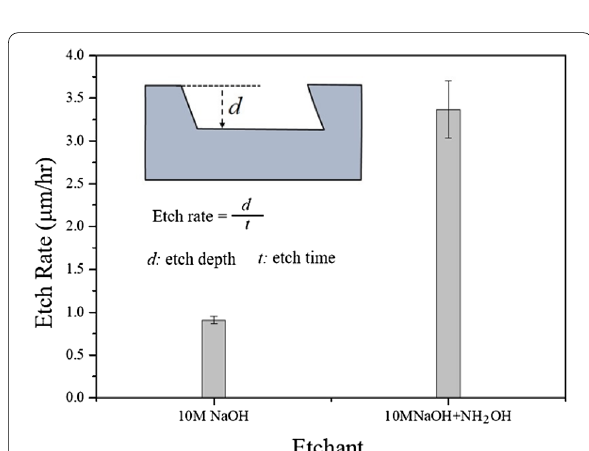
Fig. 4 Etch rate of Si{111} in pure and NH 2 OH-added NaOH at 70